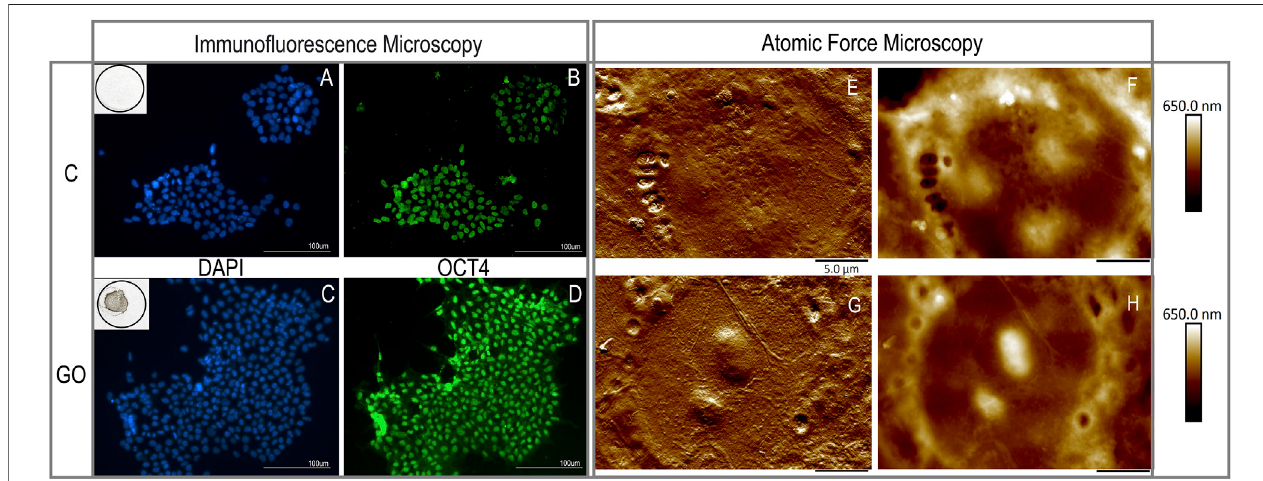
FIGURE 1 | Micrographs of fi xed hESCs grown for 2 days on Geltrex base matrix [top row; control (C)] or on the Geltrex/ graphene oxide compound substrate [bottom row; (GO)]. Parallel cultures of hESCs were processed for immuno fl uorescence (left panel) or atomic force microscopy (AFM; right panel) analysis. Under the culture conditions described, there were no signs of substrate induced toxicity and cell death, as demonstrated by the intact cell nuclei stained with DAPI (in blue; (A,C) ) orlossofpluripotencyanddifferentiation,asdemonstratedbythepluripotencymarkerOCT4evidentlypresentinallhESCs(images (B,D) ).Thetopographyandthe peak force error signal of a single cell is imaged in each of the AFM images (G top, GO bottom row; (E,G) for peak force error, (F,H) for surface topography showing the surface topographical properties of the cells).